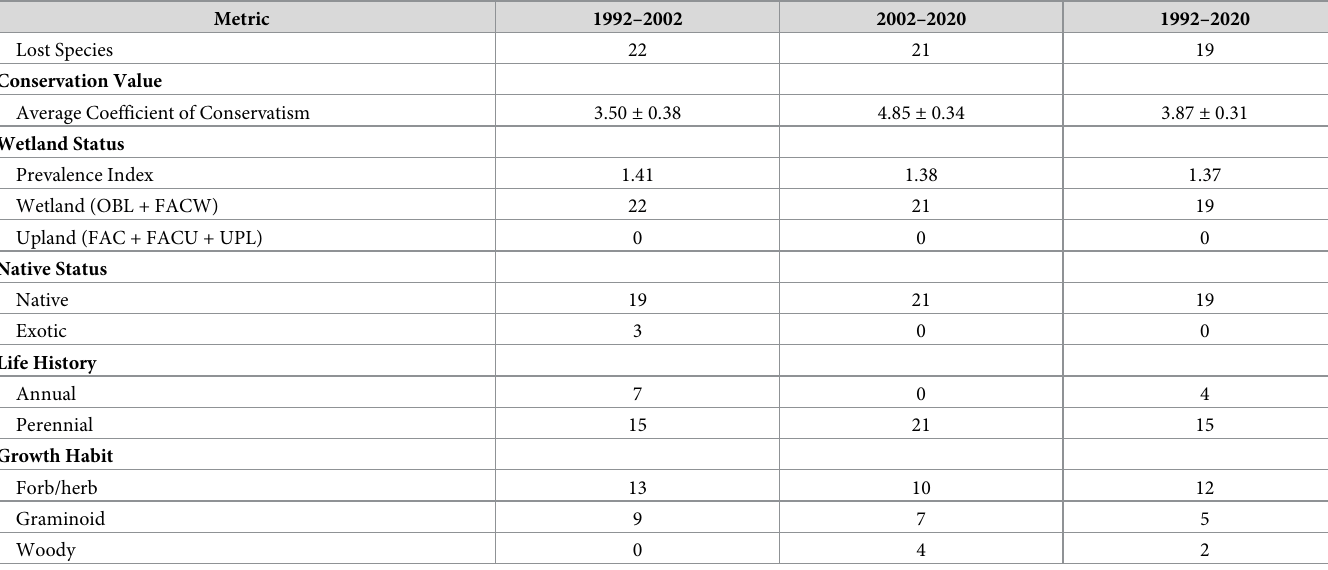
Table 3. Descriptions of the species lost between floral surveys of Quarry Pond.